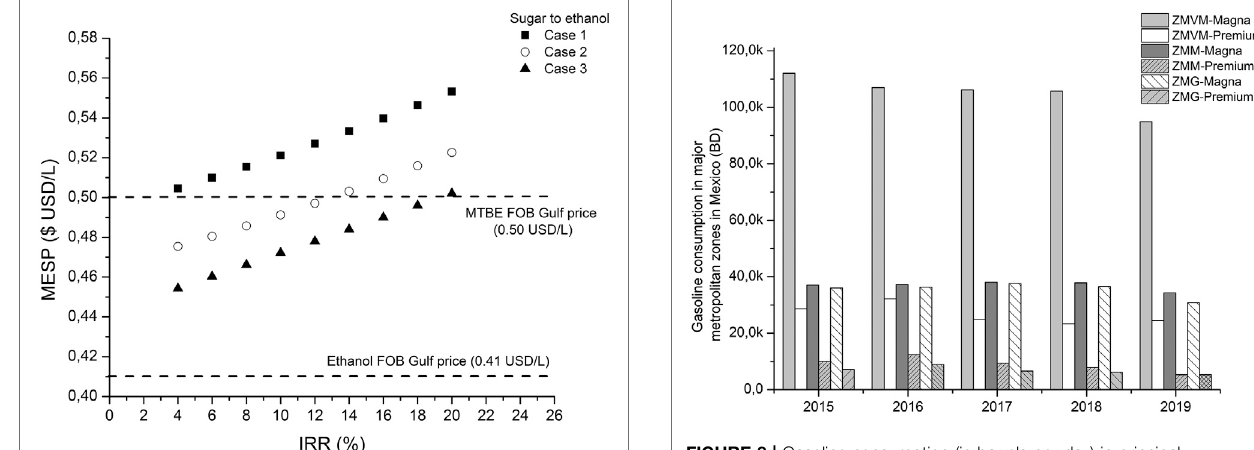
FIGURE 8 | Gasoline consumption (in barrels per day) in principal metropolitan areas (MA) in Mexico: Mexico City (ZMVM), Monterrey area (ZMM), and Guadalajara area